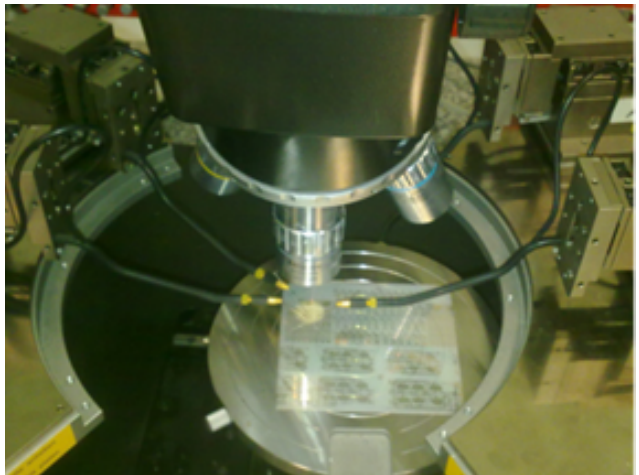
Figure 9. Probe with device under test already